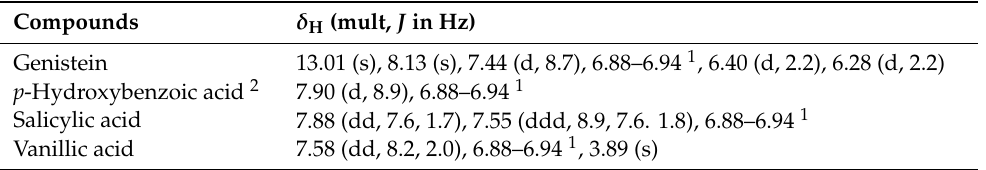
Table 1. Chemical shifts ( δ H ) and assignment of major compounds present in the D-4 and D-5 subfractions.